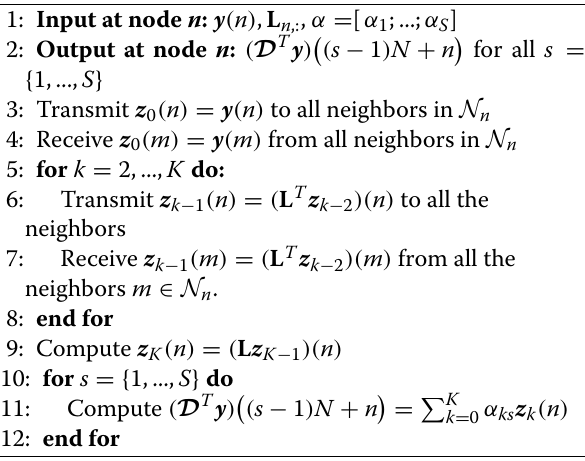
Algorithm 1 Distributed computation of D T y